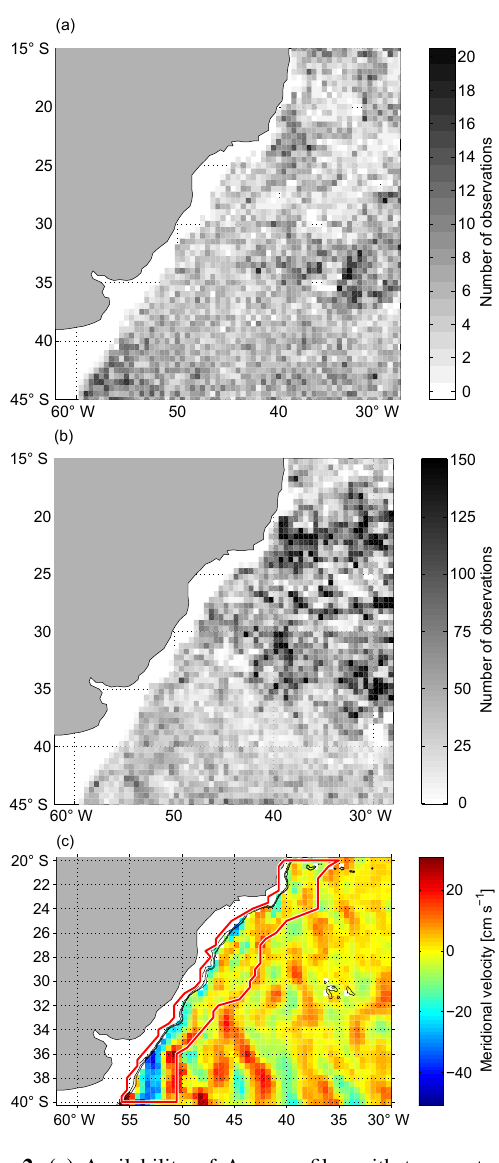
Figure 2. (a) Availability of Argo profiles with temperature and salinity in the study region for observations collected in the years 2000 to 2015. (b) Availability of trajectory observations in the study region for observations collected during January 1992 to April 2016. (c) Meridional velocity in the surface layer from Argo&SSH for January 2015. The coastline as well as the 400, 800, and 1000m isobaths are shown. The region encompassed by the red line indicates the search area for the southward flow of the Brazil Current. The bin sizes are 0.5 ◦ by 0.5 ◦